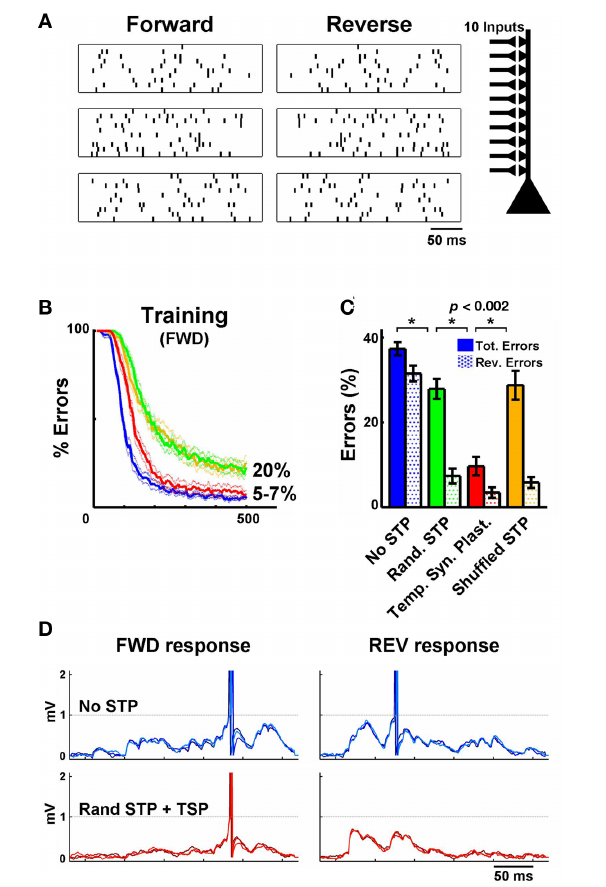
FIgure 2 | Temporal synaptic plasticity enhances the discrimination of complex spatiotemporal patterns. (A) Sample of three (out of five) spike patterns of one stimulus set – three forward patterns and their reverses are shown. Each pattern is composed of 10 inputs. (B) Performance during training on the FWD patterns in an IAF neuron. The blue line depicts learning without short-term plasticity and the green line depicts training when synapses were assigned random but fixed STP values. In the red line condition synapses were “metaplastic,” i.e., U underwent long-term plasticity, guided by the temporal synaptic plasticity learning rule. The yellow line depicts retraining with the shuffled STP values obtained from the simulations shown in red again in the absence of STP plasticity. The tempotron learning rule alone (no STP) performed well (blue), yielding 5–7% errors. Here an error is a failure to detect the target (forward) pattern or firing to any of the non-target patterns. Training for longer periods (2000 trials) or stopping training when a fixed error level is achieved (e.g., 20%) yields results similar to the ones shown in (C) . (C) Performance during testing. Filled bars represent total errors (FWD + REV), and the dotted bars represent the REV errors (e.g., an output unit trained to recognize pattern #1 responded to pattern #1 presented backwards). Notice that the inclusion of synapses with random (but “fixed”) STP values before training improves performance significantly (green). However, using temporal synaptic plasticity to tune STP (starting with random values) further decreases the number of errors (red). (D) Top row: Response of IAF neuron trained to recognize the stimulus shown in the first row of A (three overlaid test presentations are shown). Synapses do not exhibit short-term plasticity. Bottom row: as above, but synapses exhibit STP, whose parameters were adjusted by the temporal synaptic plasticity learning rule during training. Notice the effectiveness of temporal synaptic plasticity in preventing the neuron to fire to the reverse pattern. Each plot shows three trials represented in different shades of blue